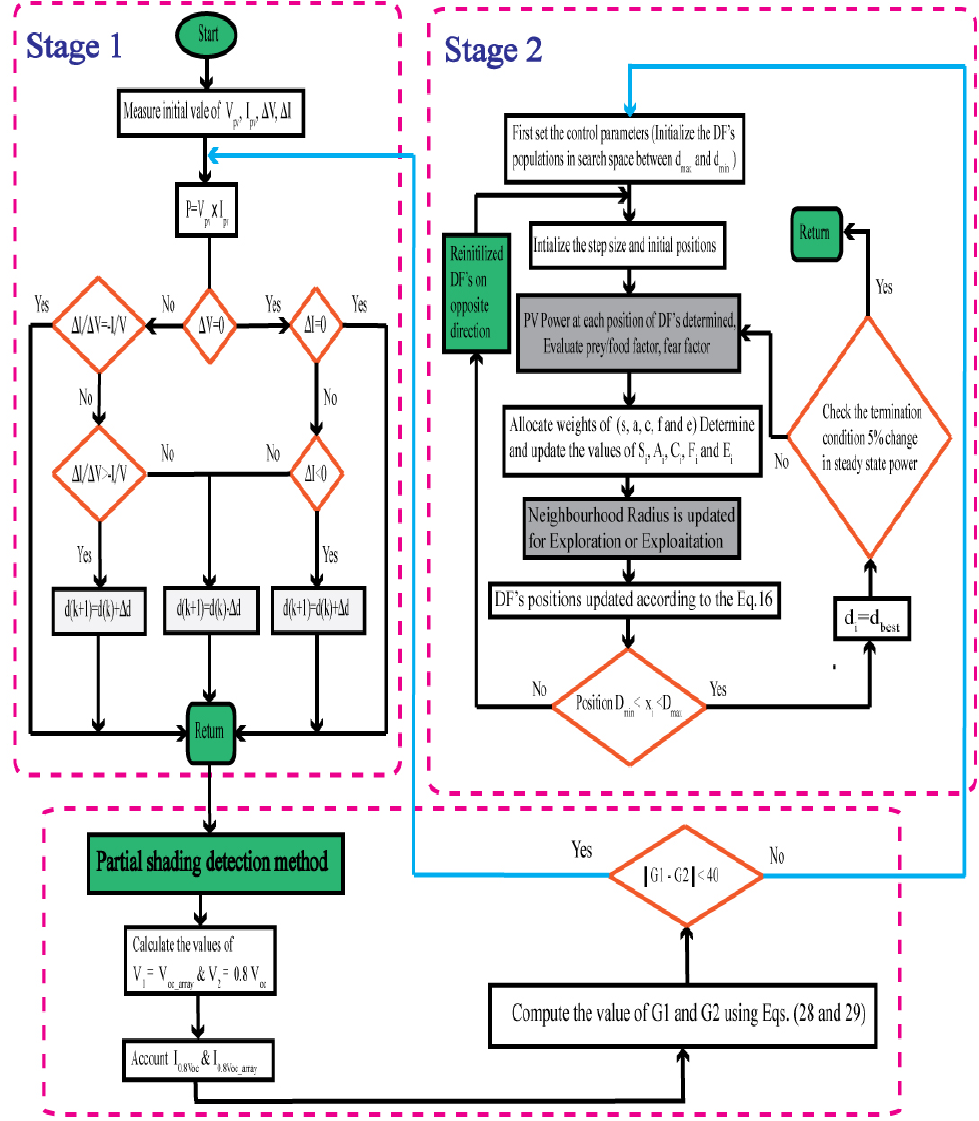
Figure 8. Flowchart of Proposed Hybrid (InC-DFO)